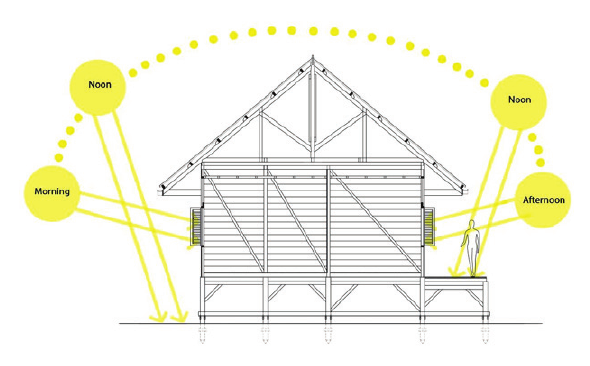
Figure 12. Natural lighting concept